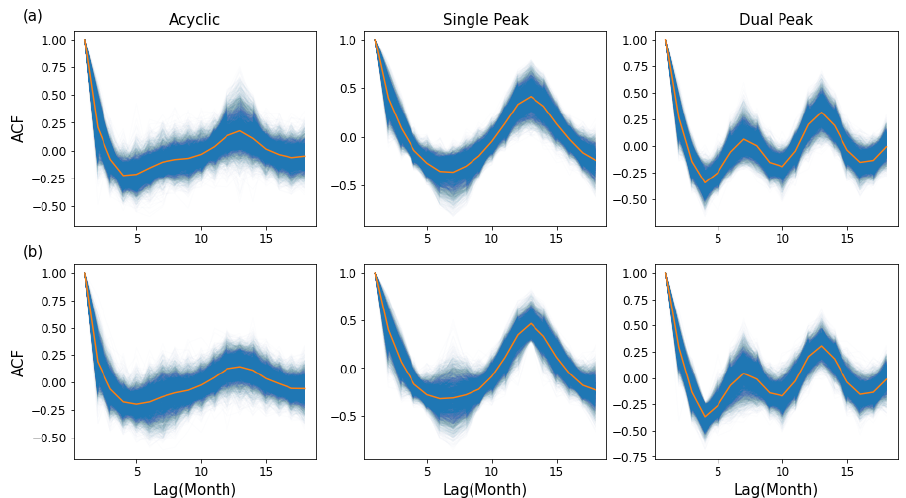
Figure 17. Cycle classification results’ verification with 5000 random samples for each class. ( a ) Top row showing results from rule based classification. ( b ) Bottom row showing results from supervised